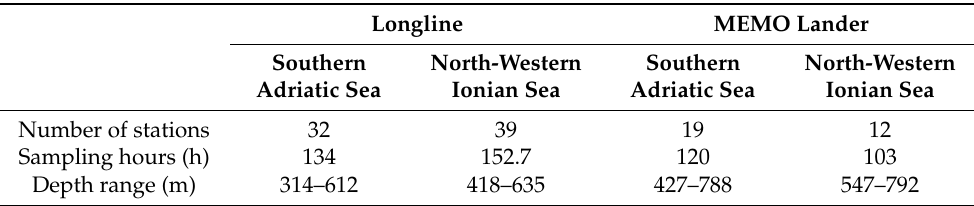
Table 1. Sampling data for each area and tools, with an indication of the depth range explored and number of